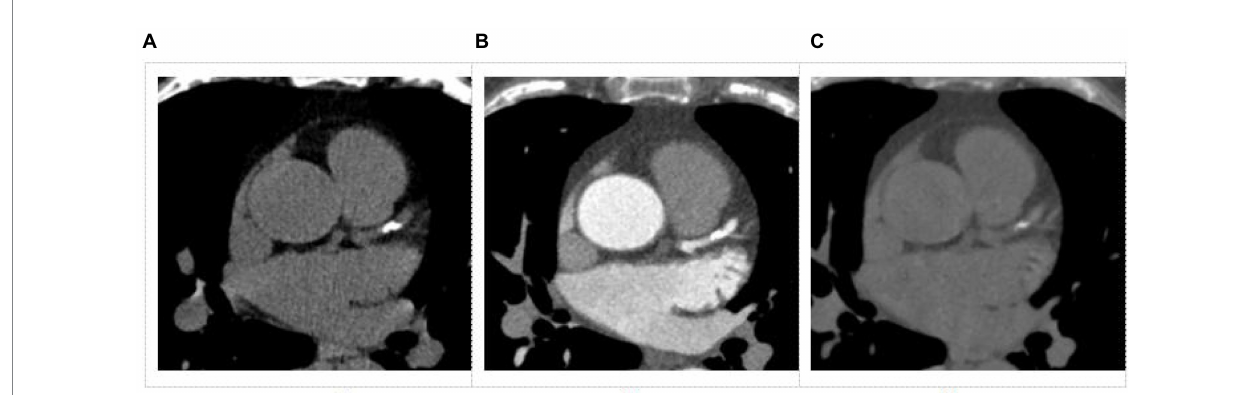
FIGURE 2 Images obtained from a dual-layer spectral detector CT for coronary artery calcium score. (A) Conventional non-contrast image, (B) Coronary artery CT angiography (CCTA) image, (C) Virtual non-contrast image from a CCTA